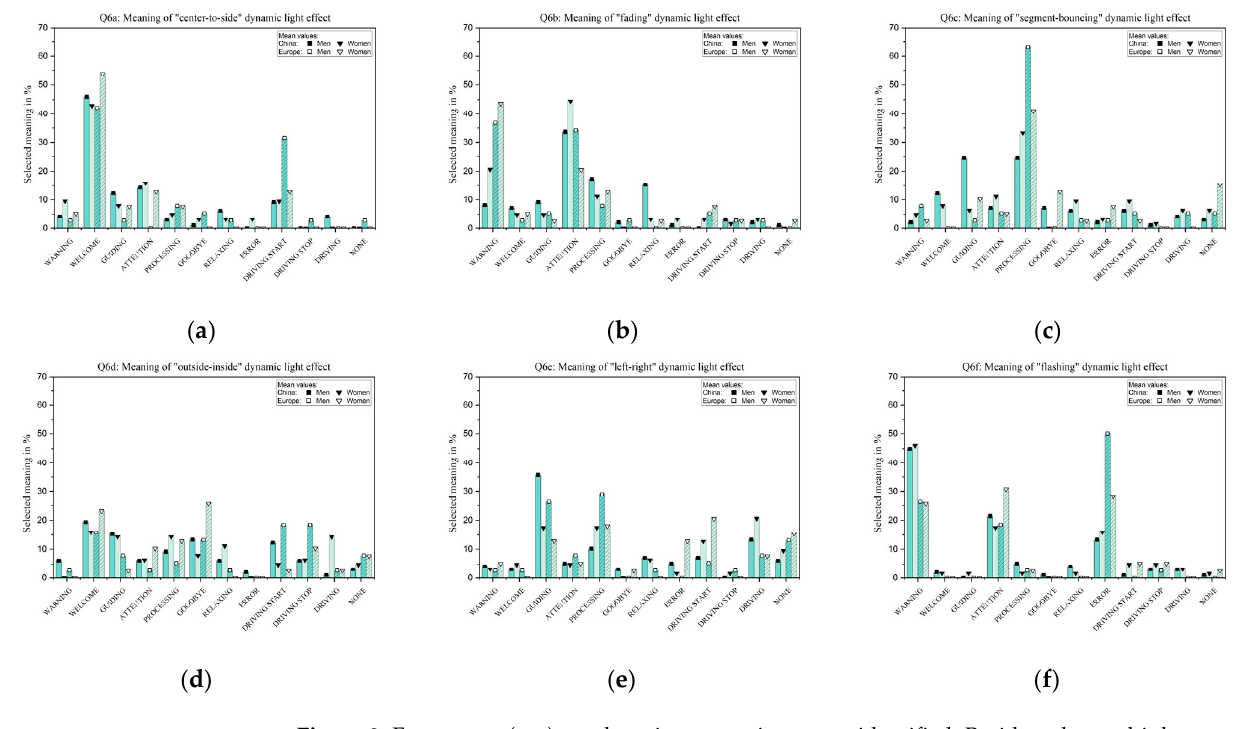
Figure 9. For pattern ( a – c ) nearly unique meanings were identified. Besides, also multiple meanings were selected as shown in ( f ). For ( d,e ) no clear pattern meaning was identified.